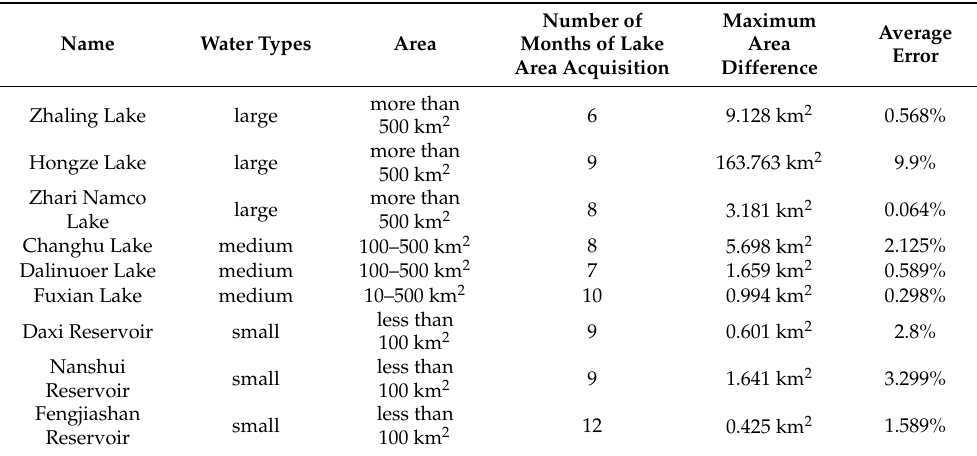
Table 2. Lake area detail comparison for accuracy